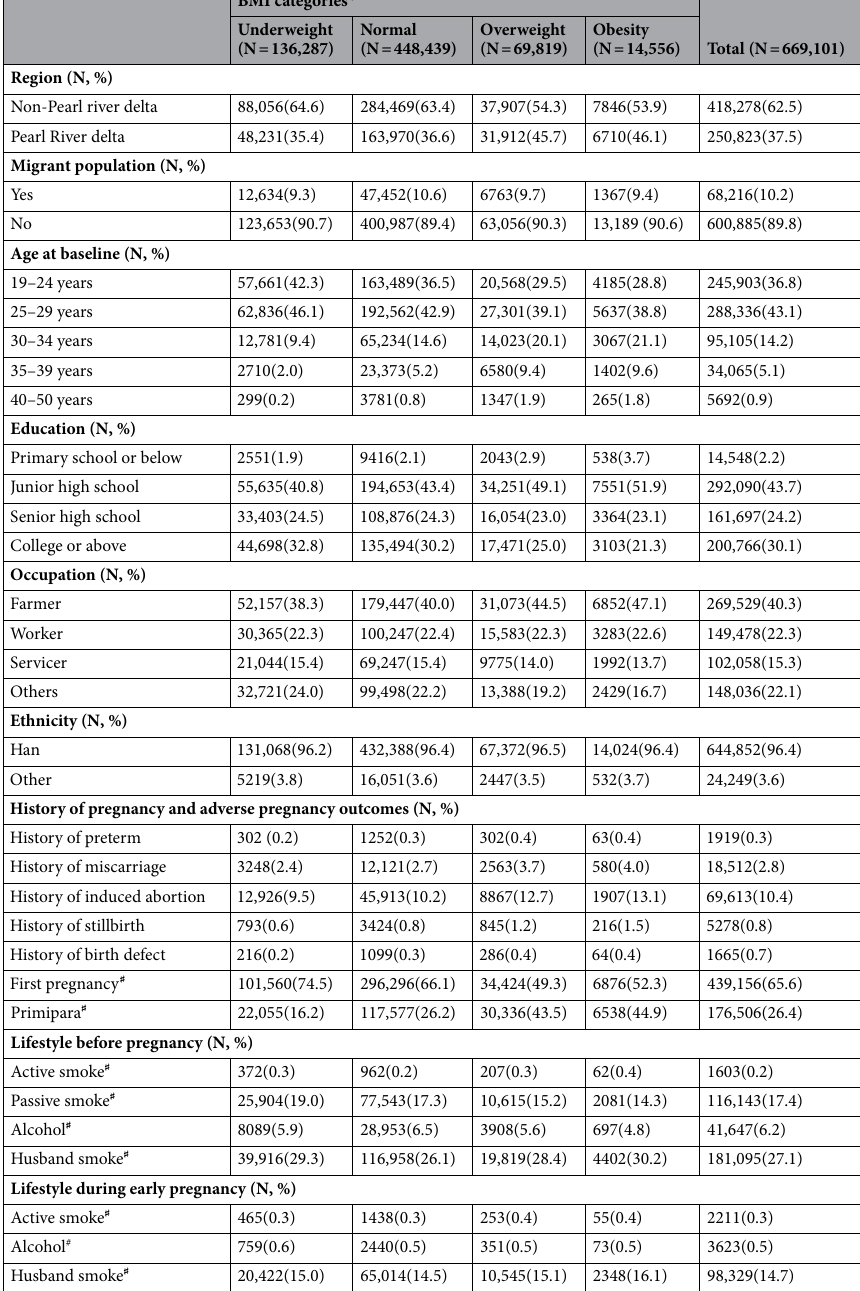
Table 1. Maternal baseline characteristics according to pre-pregnancy BMI. ♯ Missing data existed. *The distributions of BMI categories with respect to different baseline characteristics were all statistically ( P < 0.05), except for ethnicity, smoking, drink during the early stage of